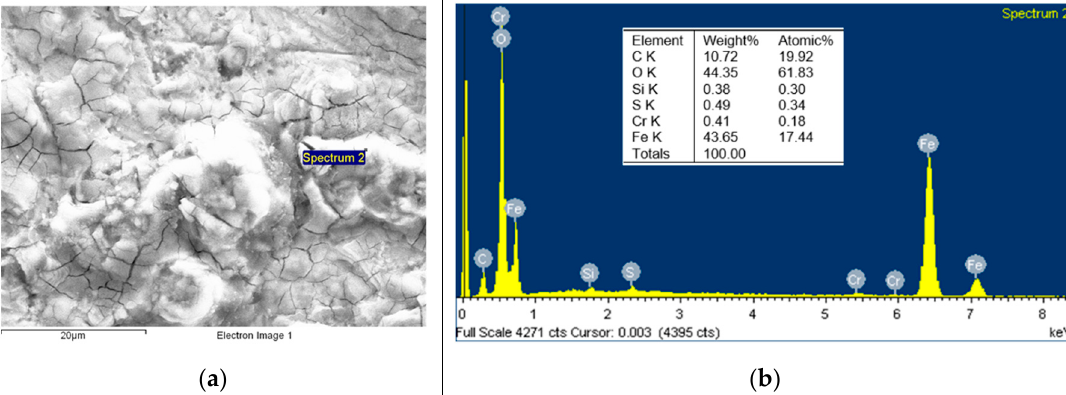
Figure 10. ( a ) SEM image and ( b ) EDS spectrum for discs tested against the PA46M sample.